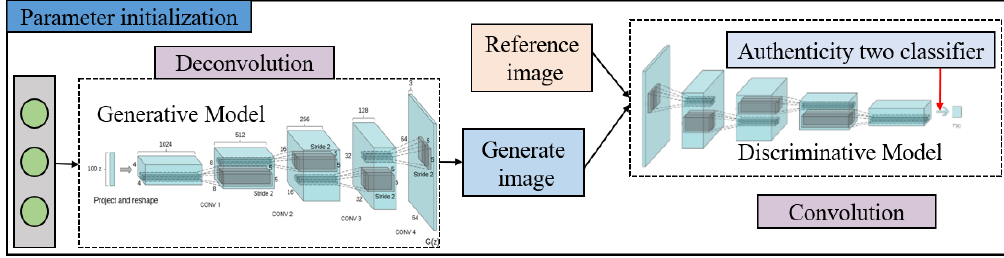
Figure 2. Network structure of DCGAN.